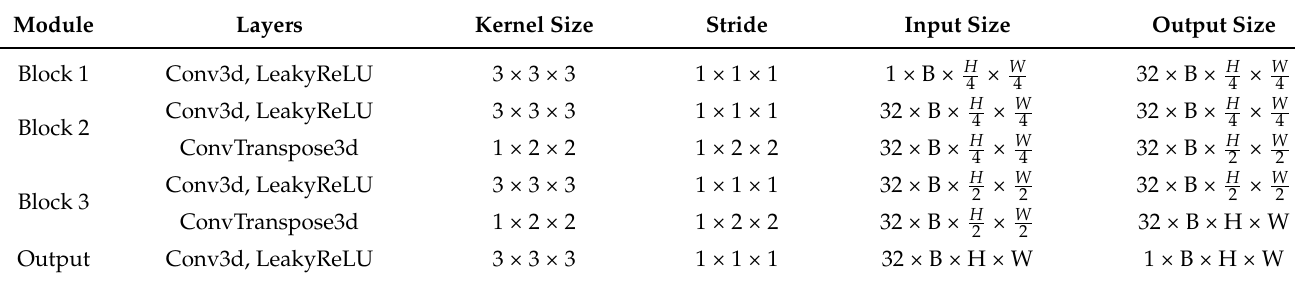
Table 4. Network configuration of the